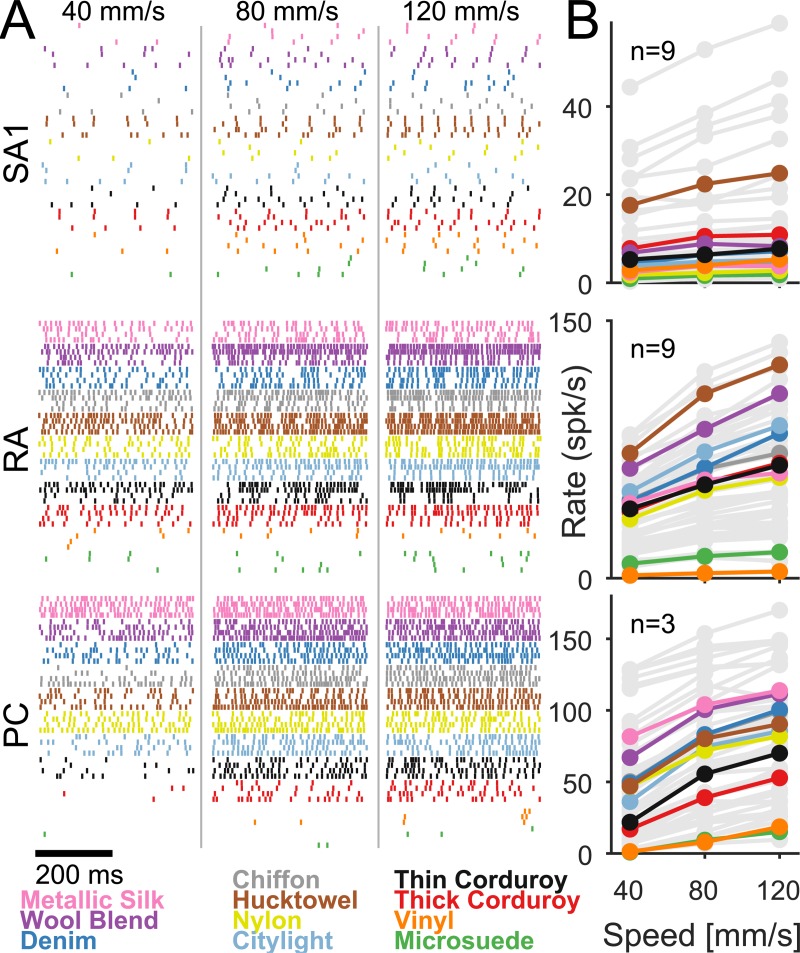
Speed dependence of the responses of tactile nerve fibers.(A) Spiking responses of two nerve fibers from each class (SA1, RA, and PC fibers) to two repeated presentations of 11 different textures scanned at three different speeds. (B) Mean firing rate across fibers of each type. Each color is a different texture (see legend at the bottom left); light gray represents the textures not used in the psychophysical experiments. Data underlying this figure can be found in S1 Data. PC, Pacinian corpuscle–associated; RA, rapidly adapting; SA1, slowly adapting type 1.